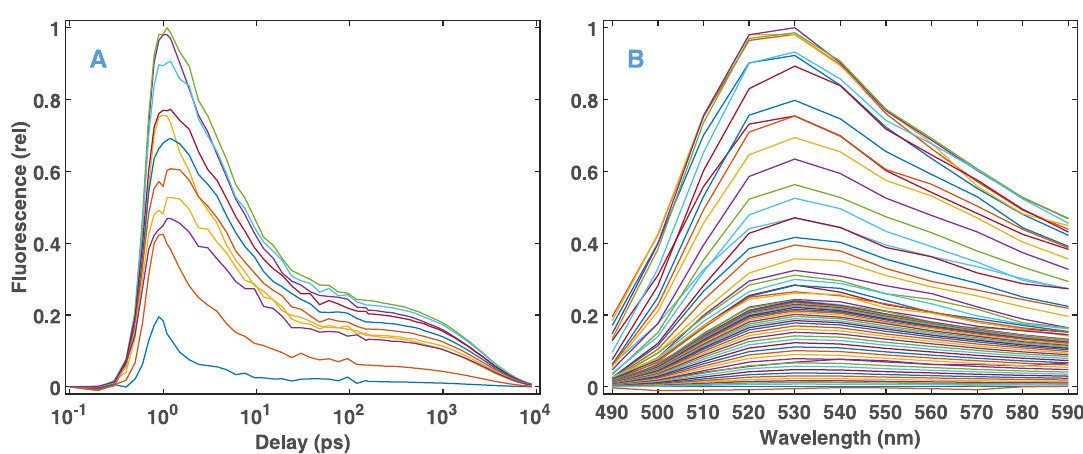
Fig 5. Experimental fluorescence kinetic data on FAD. (A)Temporal and (B) spectral representation.